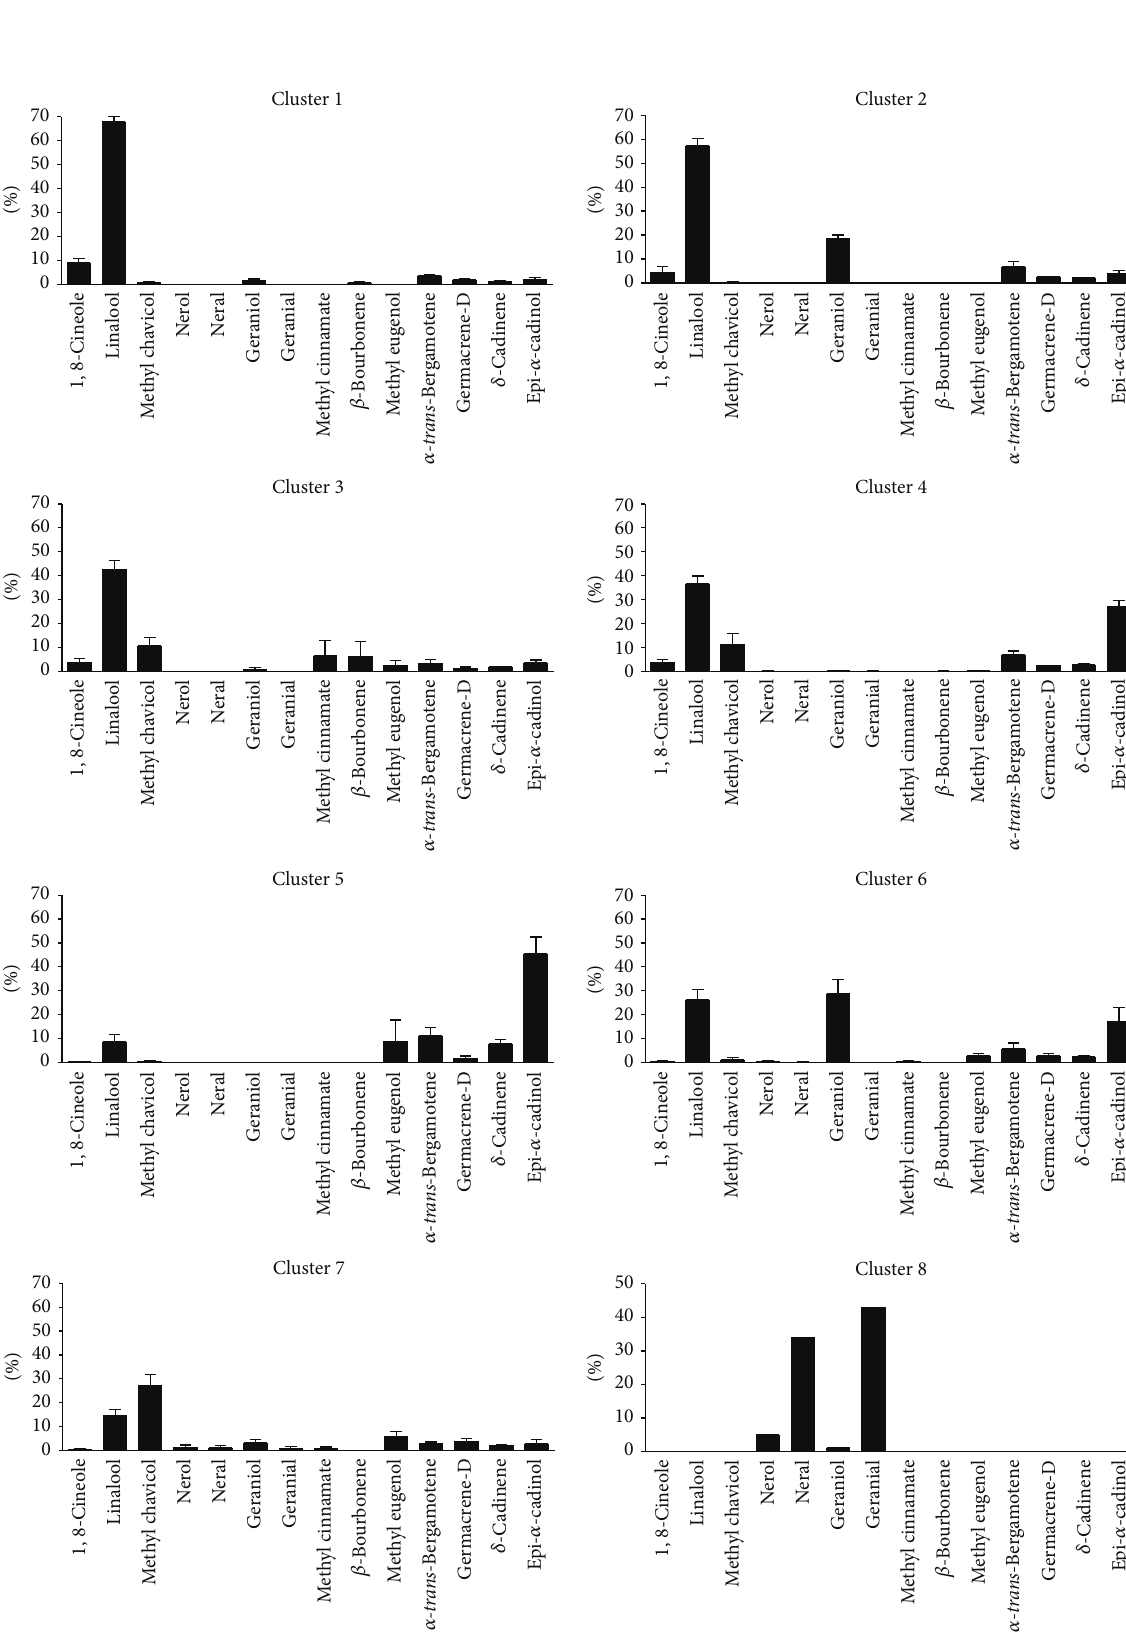
Figure 2: Means of the 14 most important chemical constituents of the essential oils of clusters 1 to 8 of Ocimum basilicum (vertical lines show ±